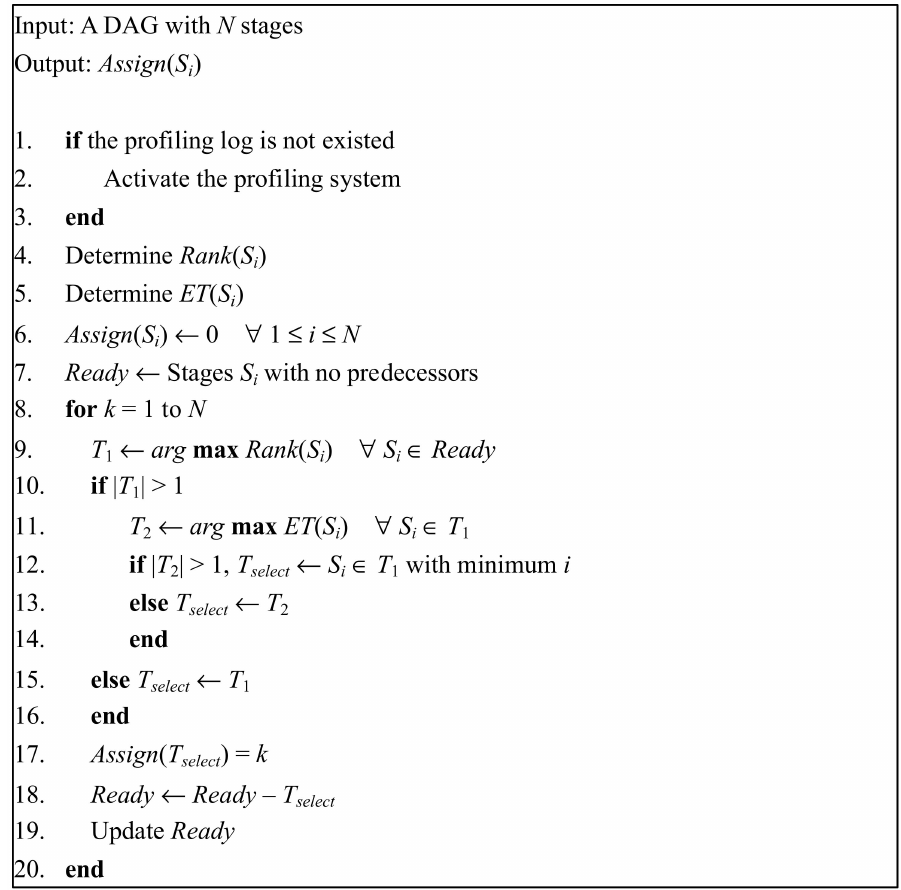
Figure 5. Pseudo-code of proposed proactive critical task scheduling